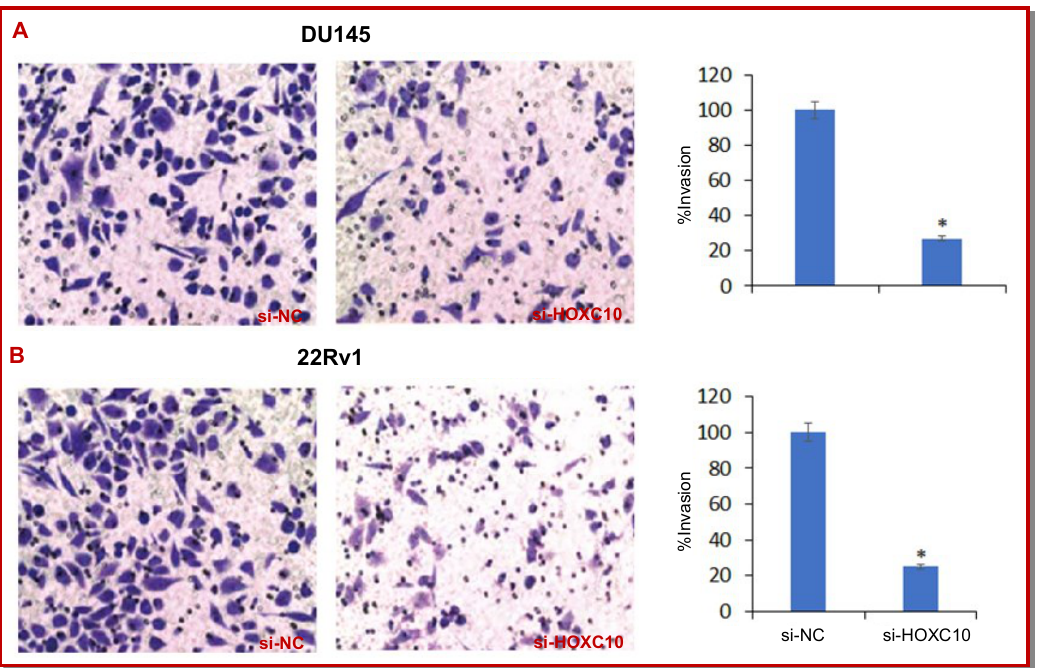
Figure 5: Silencing of HOXC10 inhibited the invasion of prostate cancer cells. A) Transwell assay showing cell invasion in si-NC and si-HOXC10 transfected DU145 prostate cancer cells; (B) Transwell assay showing cell invasion in si-NC and si-HOXC10 trans- fected 22Rv1 prostate cancer cells. The experiments were performed in triplicates and expressed as mean ± SD